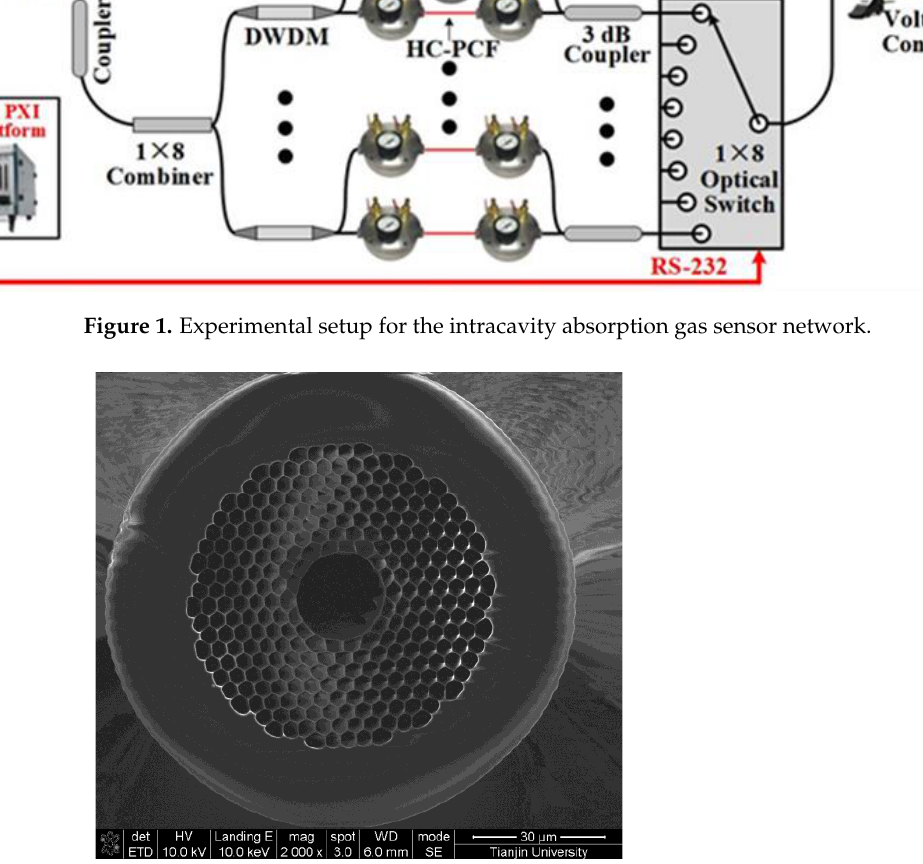
Figure 1. Experimental setup for the intracavity absorption gas sensor network.